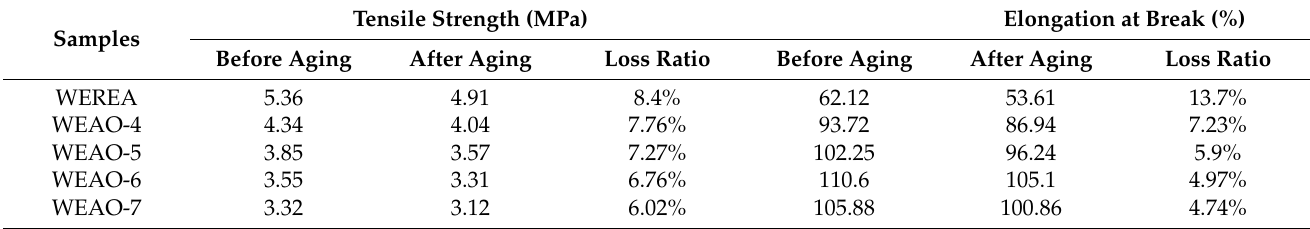
Table 4. Tensile strength and elongation of oxidized-extracted-oil-modified WEREA before and after thermal